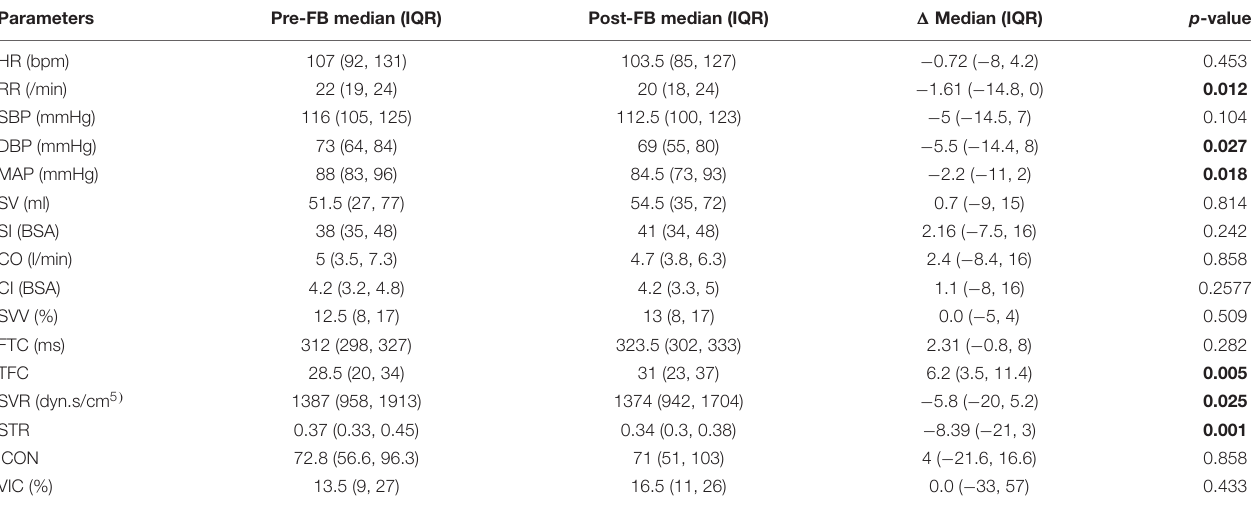
TABLE 2 | Comparison between pre- and post-FB hemodynamic